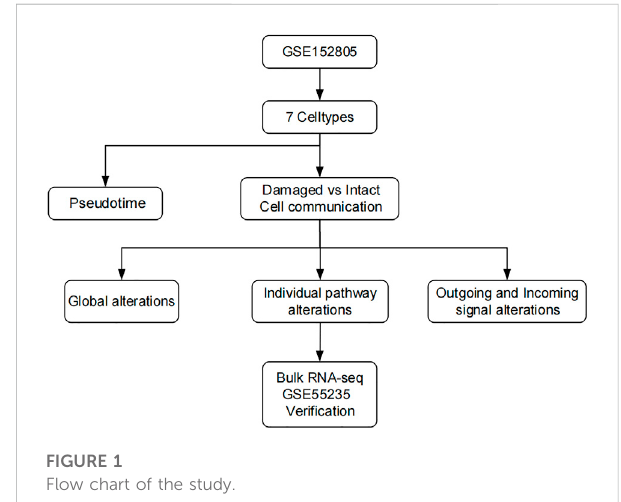
FIGURE 1 Flow chart of the